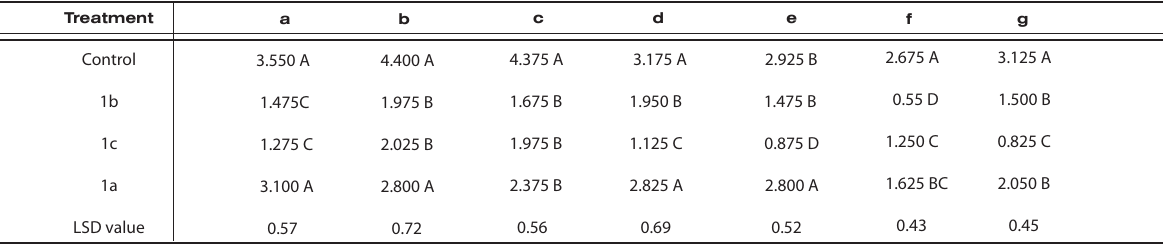
Table 3. Effect of thiourea derivatives (1a-c) on the % inhibition of fungal colonies (cm) on agar medium at 25 o C a